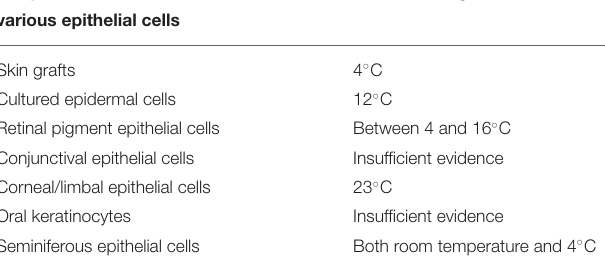
TABLE 2 | The table summarizes findings of the literature review of storage temperature for above-freezing point short-term storage of human epithelial cells. Temperature recommendations for the short-term storage of various epithelial cells Skin grafts 4 ◦ C Cultured epidermal